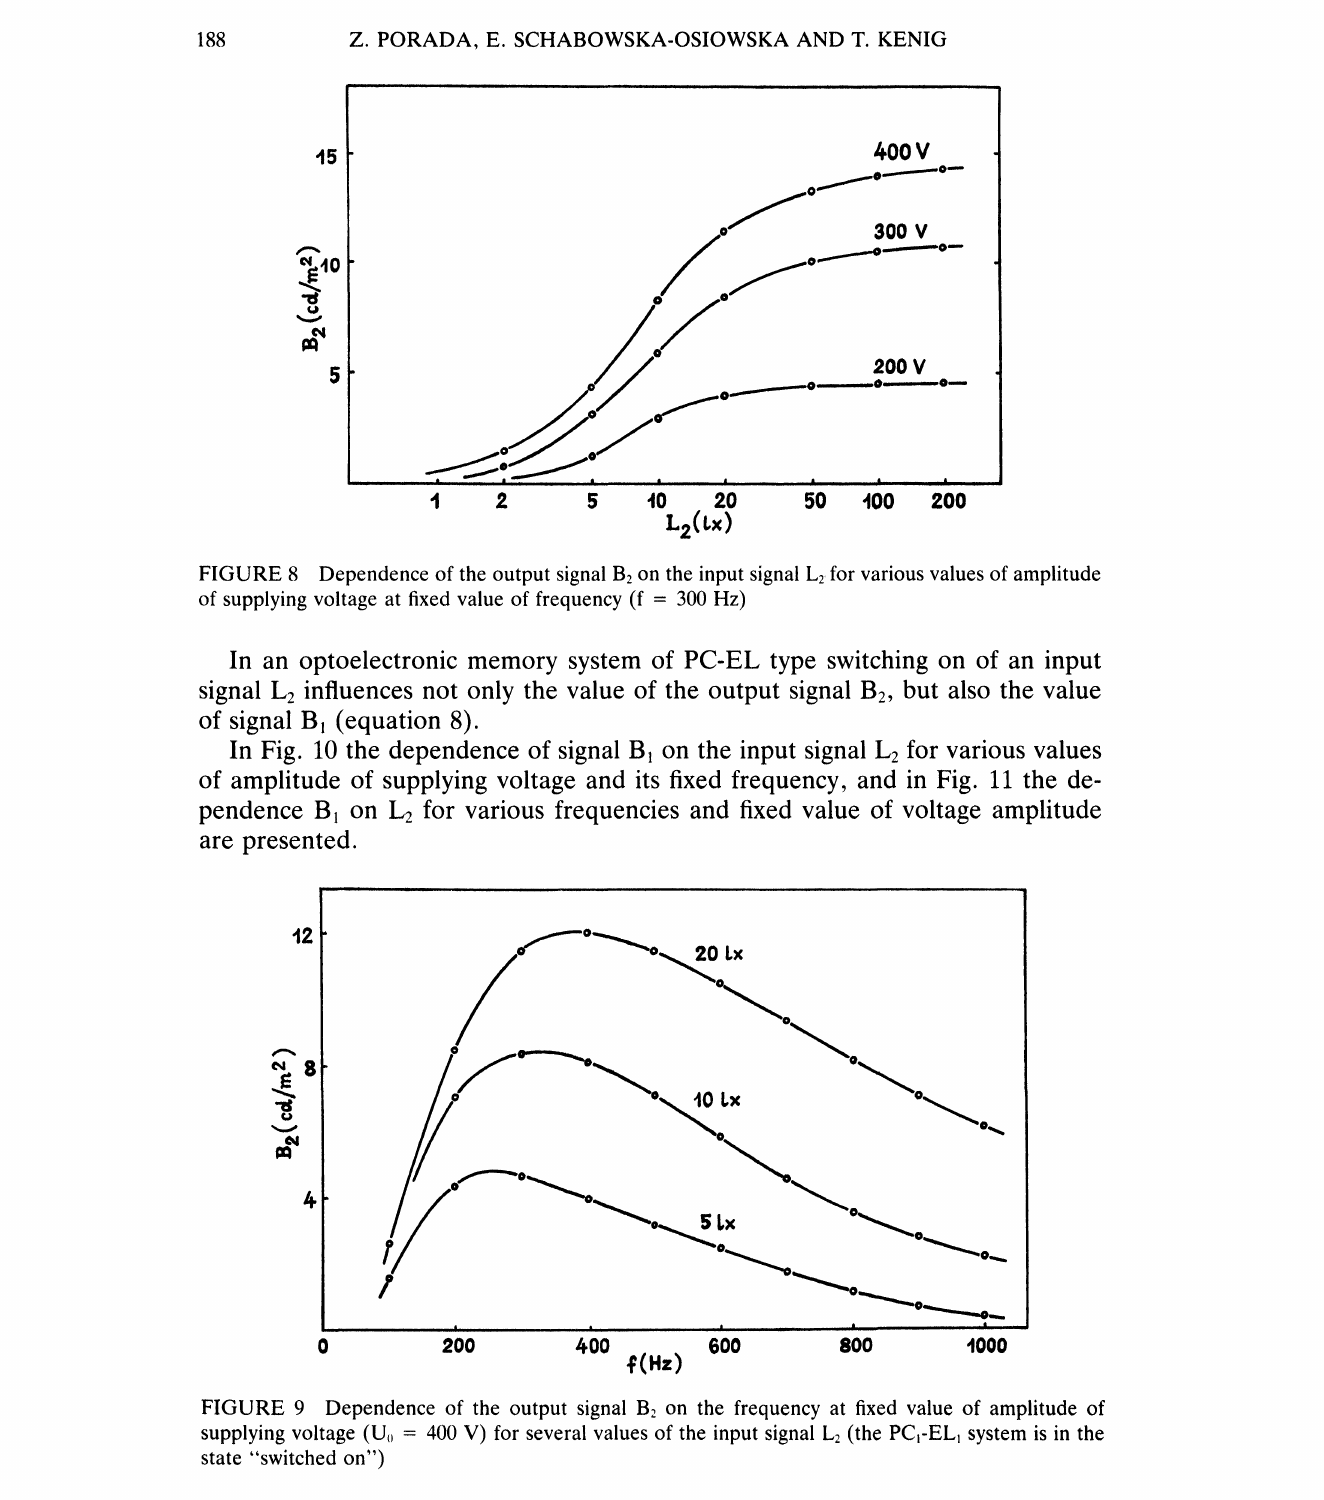
FIGURE 9 Dependence of the output signal B2 on the frequency at fixed value of amplitude of supplying voltage (U,, 400 V) for several values of the input signal L2 (the PC-EL system is in the state "switched